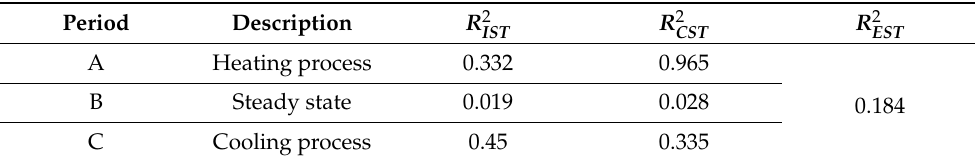
Table 3. Root mean square values for two layers wall configuration e between FEM and experimen- tal data.